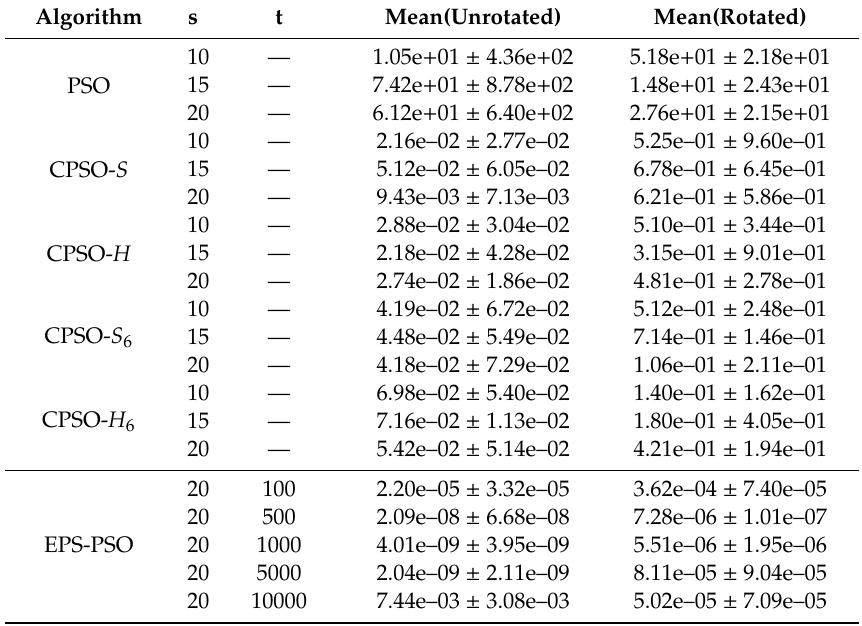
Table 6. Computational results of Griewank obtained by using 6 PSO-based algorithms after 2 × 10 5 function evaluations, averaged over 50 independent